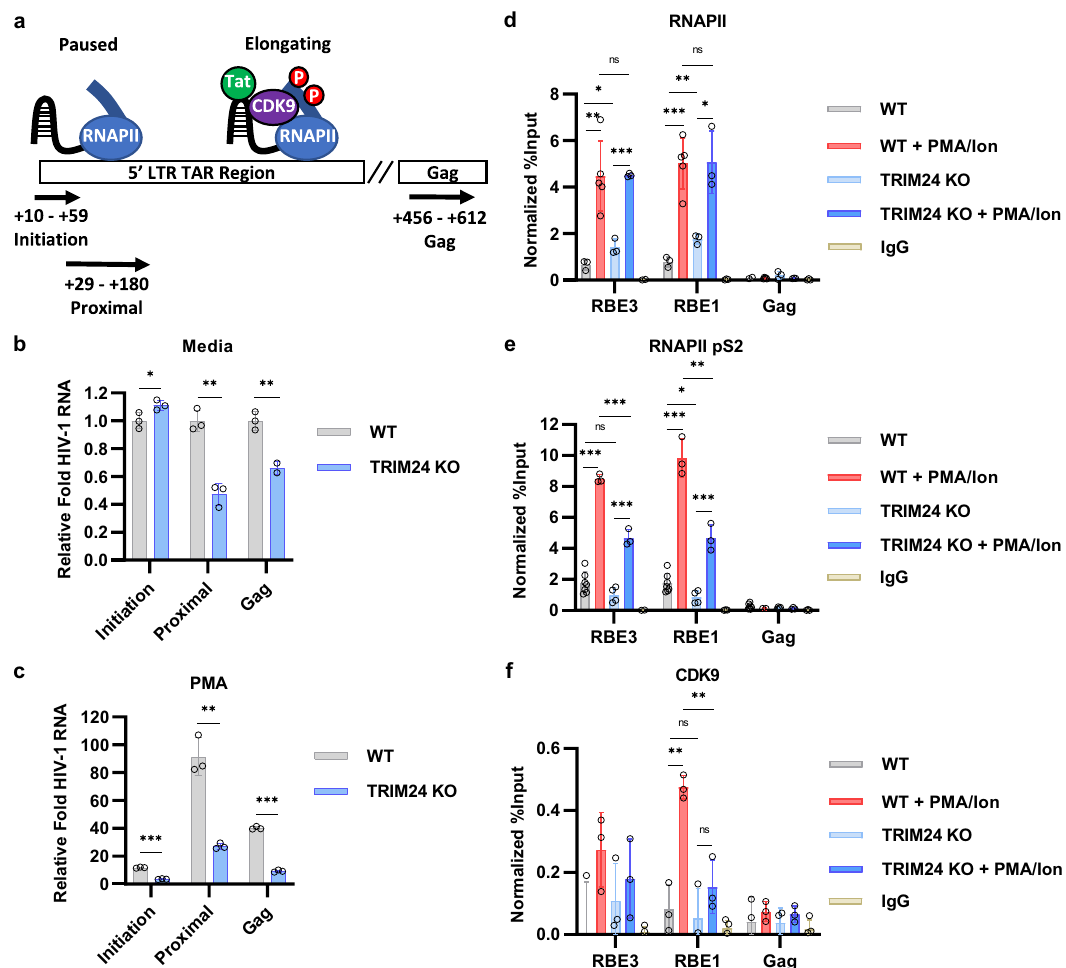
Fig. 7 TRIM24 stimulates elongation of HIV-1 transcription. a Schematic representation of the 5 ’ LTR TAR and Gag-encoding regions, indicating primer pairs used to measure Initiation ( + 10 – 59 bp), Proximal ( + 29 – 180 bp), or Gag ( + 456 – 612 bp) HIV-1 transcript abundance. b , c Wild-type and TRIM24 KO Jurkat mHIV-Luciferase cells were cultured under normal conditions ( b ) or with 20 nM PMA for 4 h ( c ). RNA was extracted, cDNA synthesized, and RT- PCR was performed using primers to detect Initiation, Proximal and Gag RNA sequences with data normalized to the untreated wild-type control ( n = 3, mean ± SD). d – f Wild-type or TRIM24 KO Jurkat mHIV-Luciferase cells were left untreated or stimulated with 20 nM PMA/1 μ M ionomycin for 4 h. ChIP- qPCR analysis was performed using anti-RNAPII ( d ), anti-RNAPII pS2 ( e ), or anti-CDK9 ( f ) antibodies. Results were normalized by subtraction of values produced with sample-paired non-speci fi c IgG ( n = 3 – 7, mean ± SD).